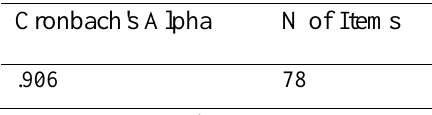
Table 5. Reliability